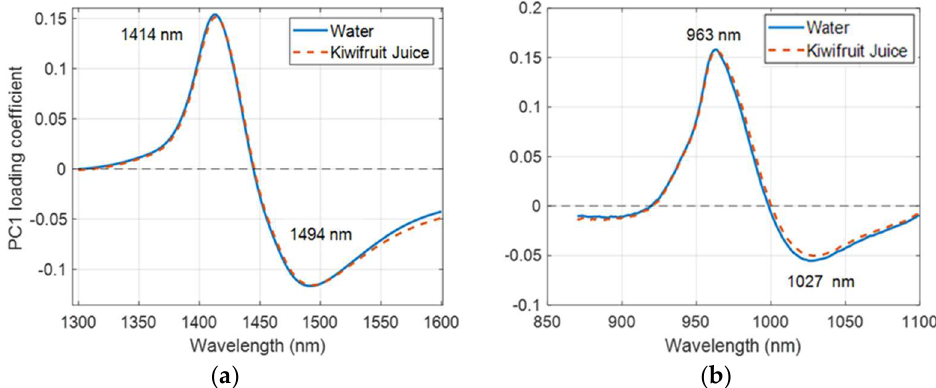
Figure 7. Average raw absorbance difference spectra of water and kiwifruit juice after subtracting average raw absorbance spectrum of water and juice at 20 °C, respectively.